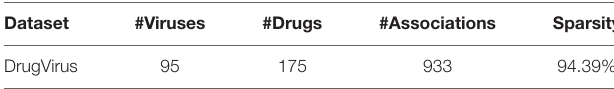
TABLE 1 | Statistics of the